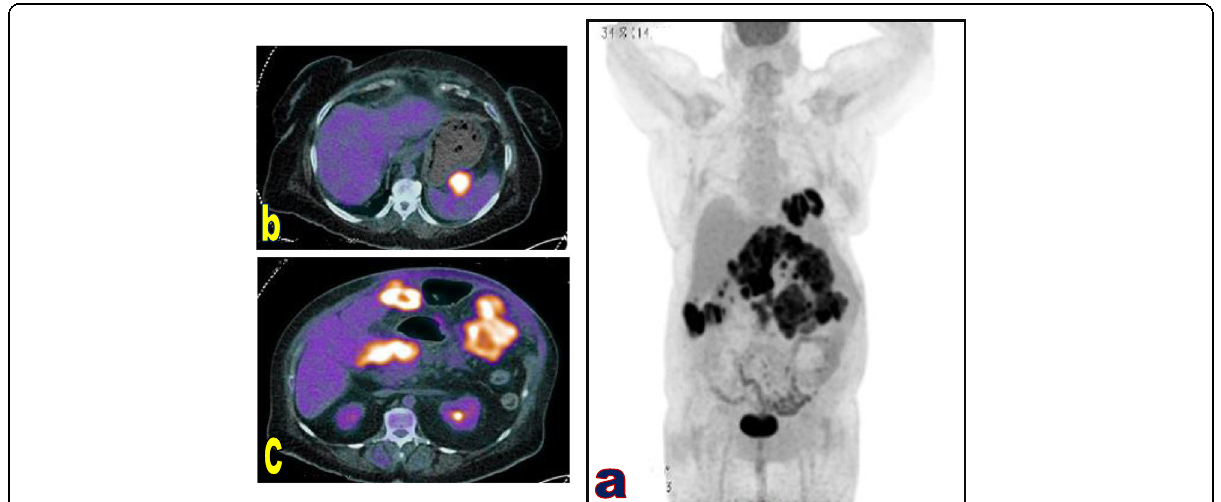
Fig. 3 3D MIP ( a ) and axial fused PET/CT images ( b and c ) for a 70-year-old female patient with history of gastric cancer underwent surgical excision. Operative bed is clear. Hypermetabolic peritoneal nodules, masses, and sheet-like infiltrates seen beneath the abdominal wall, in the mesentery, hepatic, and splenic reflections. The largest seen in the left hypochondrium related to hepatic surface at segment III. Final